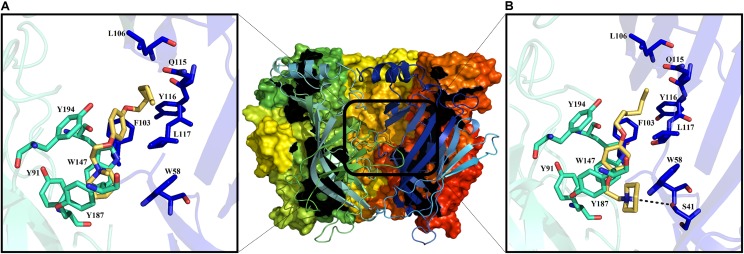
Middle: extracellular domain of the α7 nAChR. The binding site for the ligand is shown in the black rectangle. Molecular docking at the α7 nAChR active site for 12a and 11a
(A,B), respectively. Amino acid residues forming the principal (+)-side are colored in cyan, and those forming the complementary (-)-side are in blue according to the convention used for the X-ray crystal structure of Lymnaea stagnalis AChBP (Celie et al., 2004).